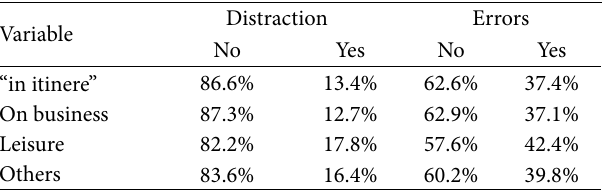
Table 5: Probabilities of suffering a serious accident, based on the reason of displacement, age and gender. Processed by the authors.